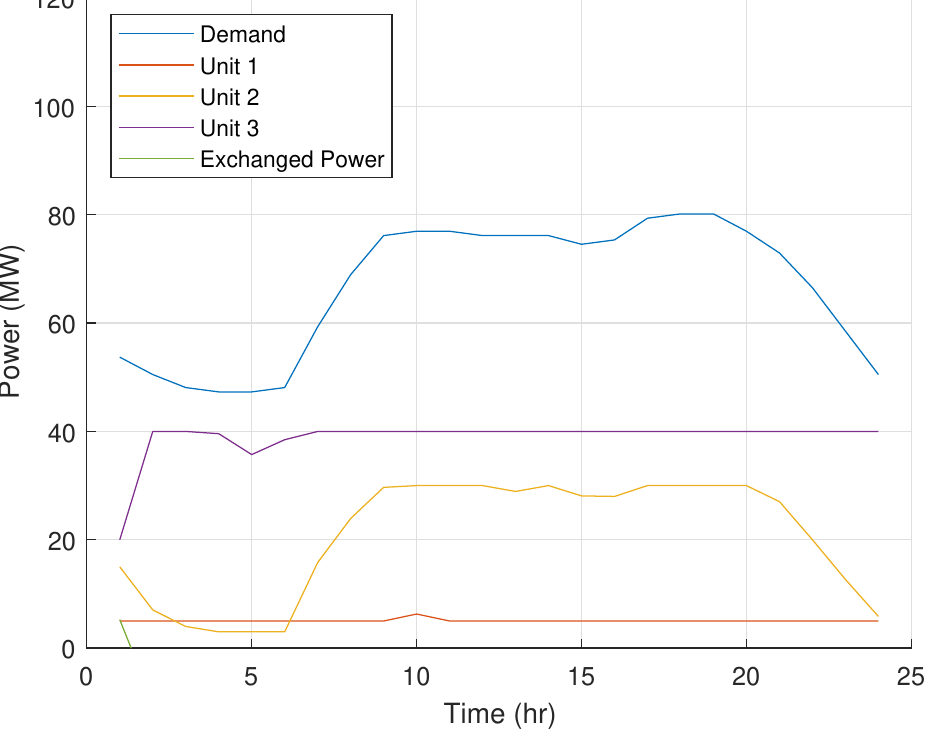
Figure 12. Economic dispatch without ESS.